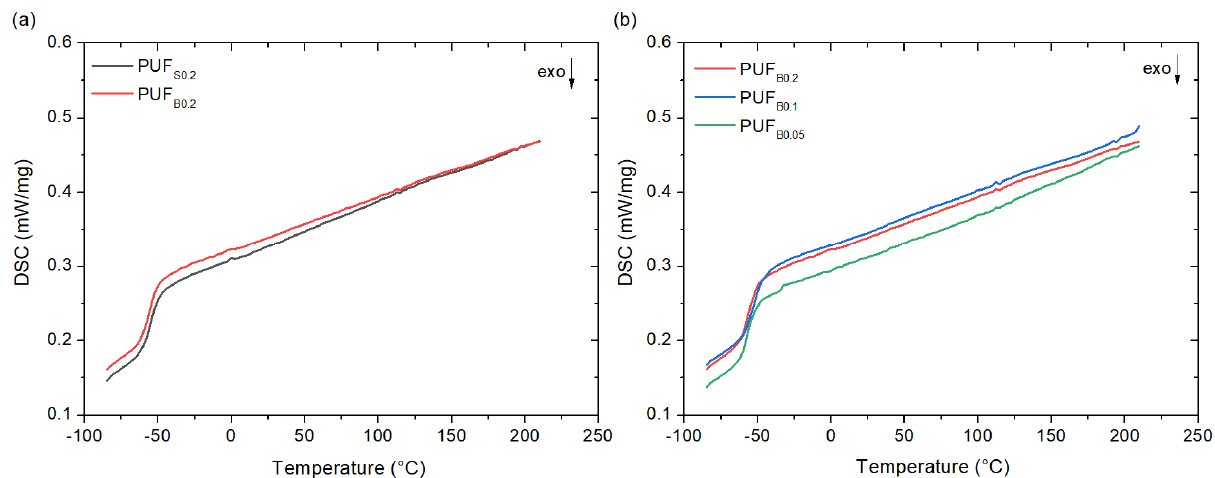
Figure 8. The DSC thermographs of: ( a ) bismuth triflate and stannous octoate; ( b ) with different amounts of bismuth triflate.